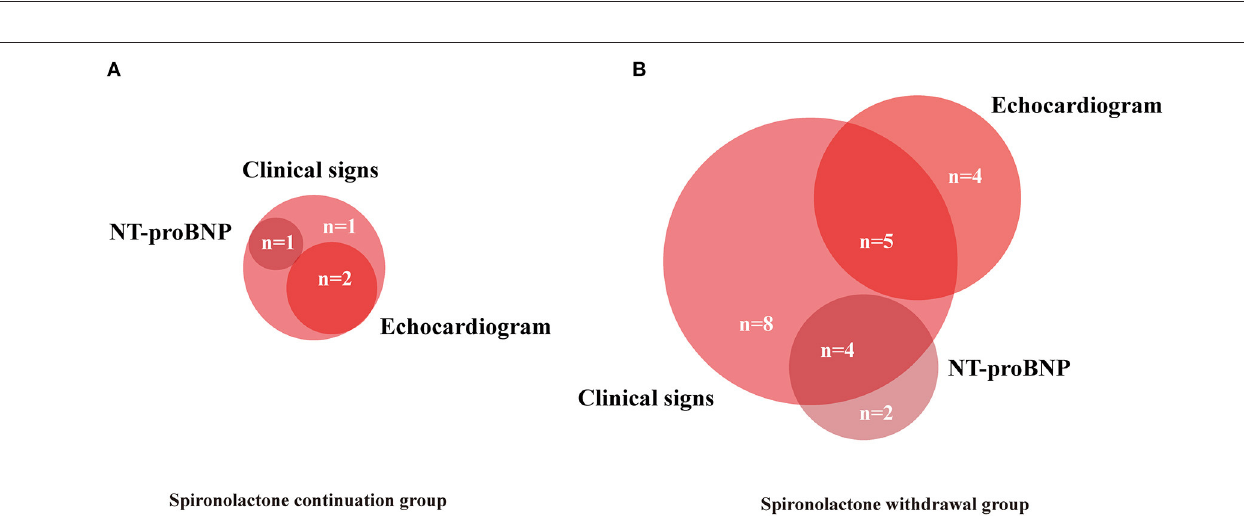
FIGURE 3 | Venn diagram showing components contributing to primary endpoints. Numbers of patients with each combination of endpoints included. (A,B) NT-proBNP, N-terminal pro-B-type natriuretic